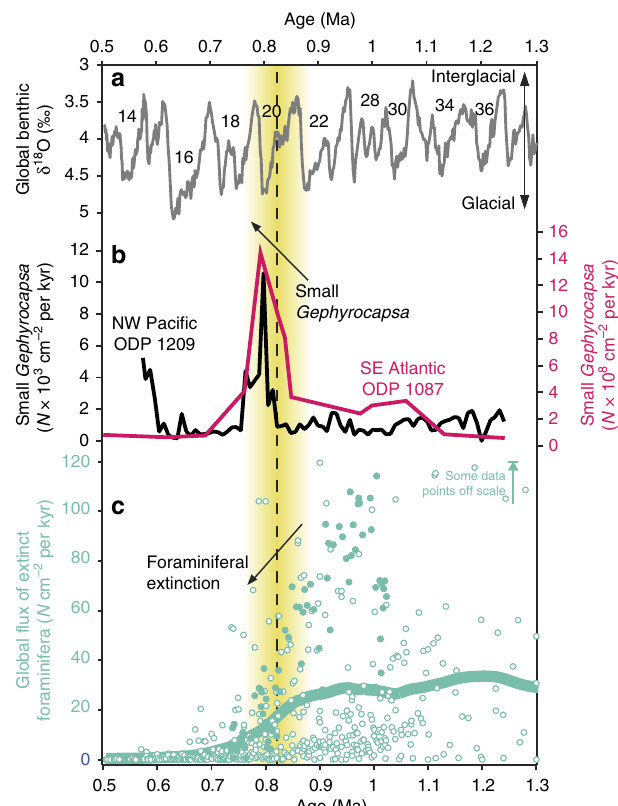
Figure 3 | Nannoplankton assemblages compared with extinct benthic foraminifera over the Mid Pleistocene. ( a ) Global deep-sea d 18 O composite 52 . ( b ) Accumulation rate of small Gephyrocapsa at Ocean Drilling Program (ODP) Site 1087 (ref. 26) and ODP Site 1209 (ref. 27). ( c ) Flux (accumulation rate) of extinct foraminifera from 15 global sites compiled by ref. 7 (open symbols), and including new data from this study (solid symbols), with a 0.2-pt LOESS smoothing spline (bold). Some data points are off the scale; smoothed line takes into account all data. Note how the peak in small Gephyrocapsa dominance at B 0.8Ma occurs in the NW Pacific and SE Atlantic (and SW Pacific and N Atlantic, Supplementary Fig. 3), and coincides with persistently low abundance of the extinction group thereafter. Vertical yellow and dashed lines as in Fig.